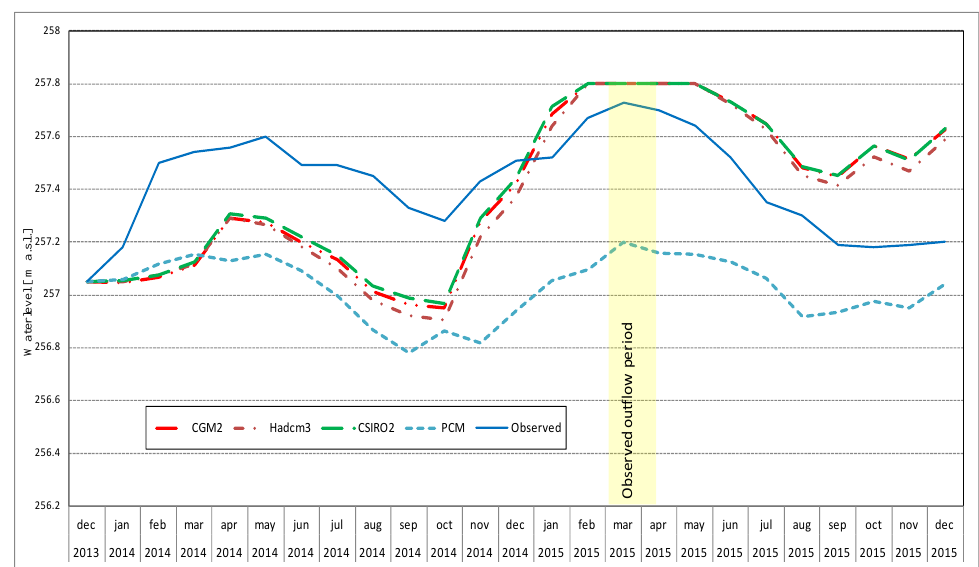
Figure 12. Lake Trasimeno levels observed and simulated in scenario A1F1, test period.